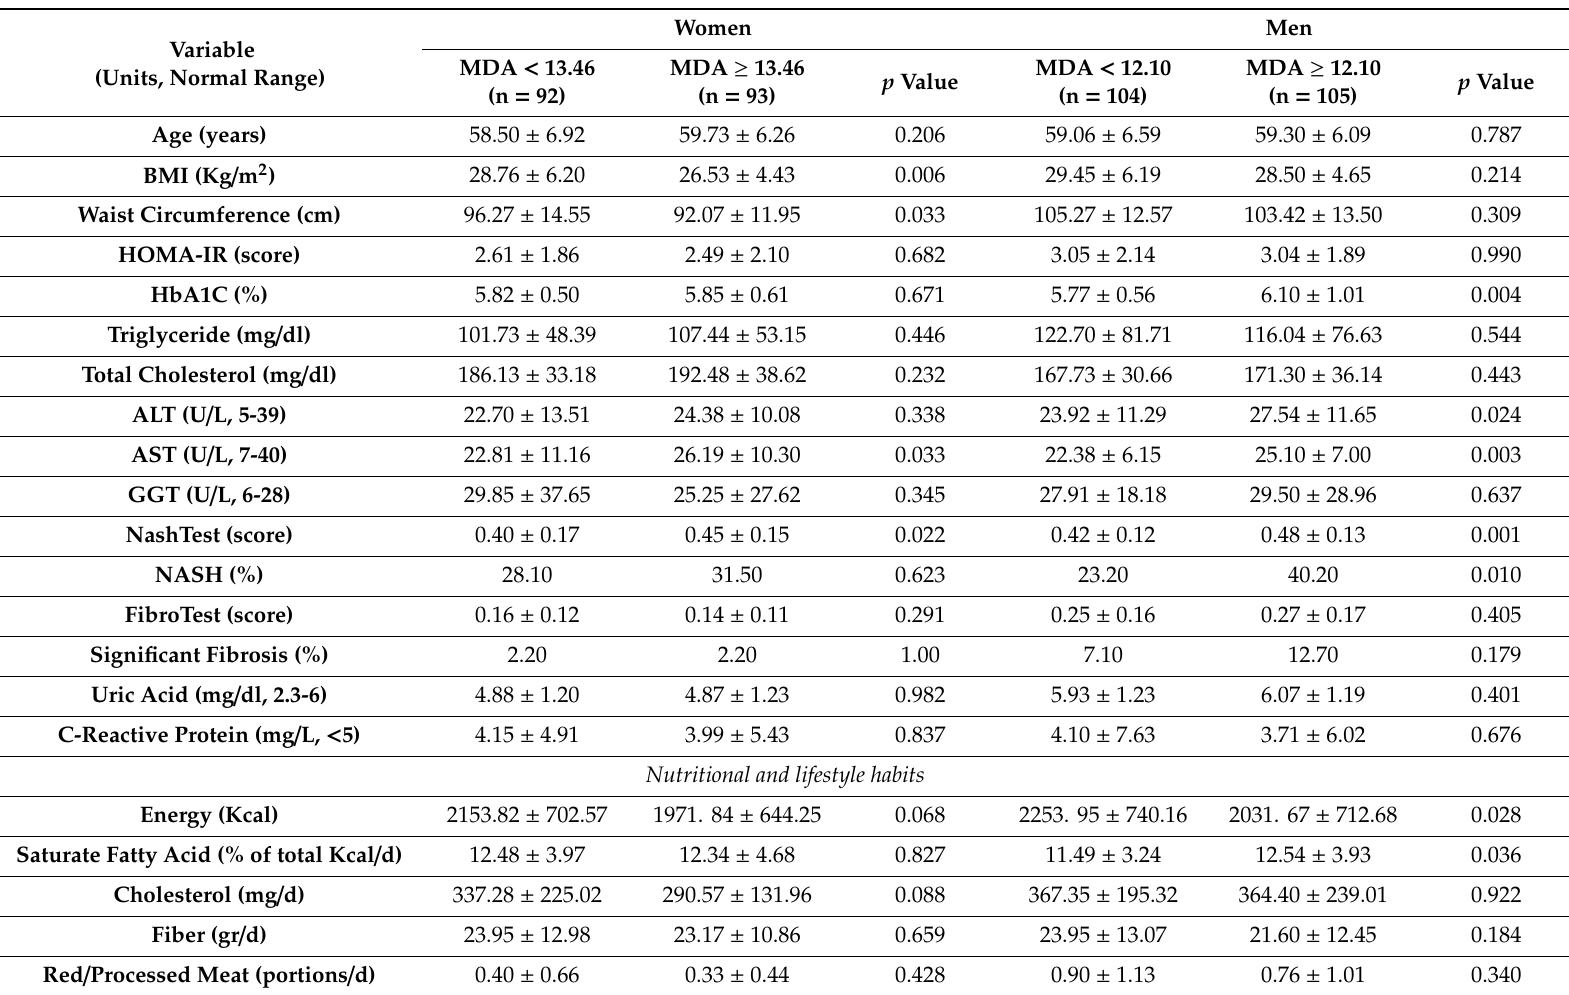
Table 1. Comparison between subjects with high and low malondialdehyde (MDA) (by gender specific median, nM) (Mean ± SD, unless otherwise stated).